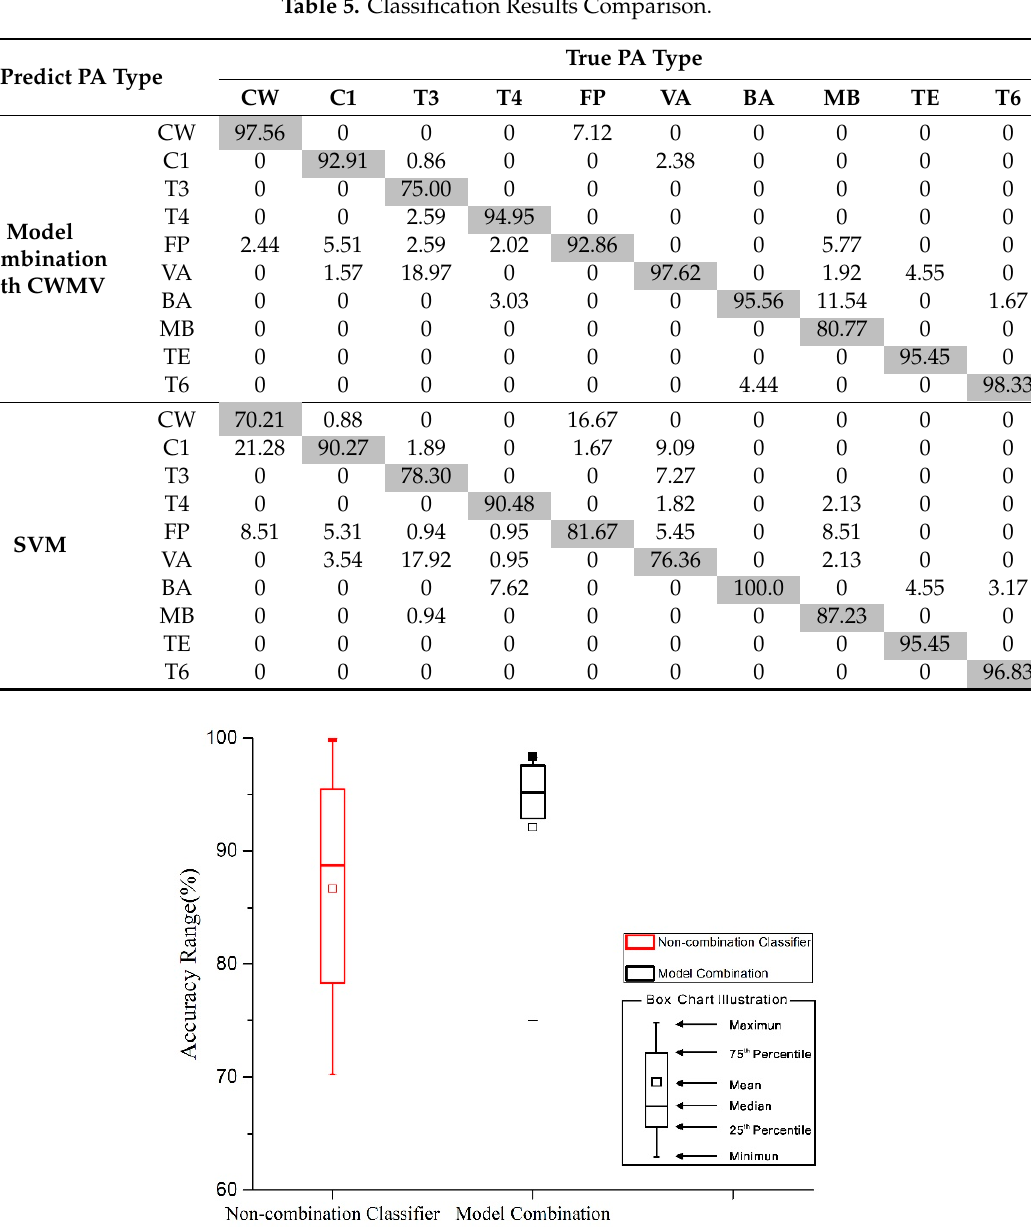
Figure 9. Statistical distributions of classification results of the model combination and non-combination SVM